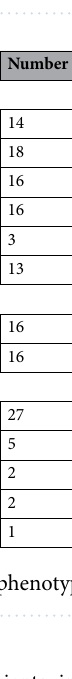
Figure 1. Pedigrees and audiograms of some of the families. All variants were identified by whole-exome sequencing and confirmed by Sanger sequencing. ( A ) Two novel variants in the CDH 23 gene were identified, c.337del, p.(Val113*) and c.3353del, p.(Gly1118Alafs*7), in a patient with Usher signs. ( B ) Two previously reported variants were identified in CDH 23: c.1515-12G > A, reclassified as likely pathogenic after manual curation, and c.1096 G > A, p.(Ala366Thr) classified as benign based on its high population frequency. ( C ) Postlingual bilateral moderate hearing loss caused by a novel heterozygous variant in EYA 4: c.580+2T > C (splicing). ( D ) One-year-old boy with nonsyndromic isolated prelingual hearing loss and no retinal or vestibular pathologies at the time of study. Novel variants c.733C > T, p.(Gln245*) and c.1344-2A > G (splicing site mutation previously reported in ClinVar) in MYO7 A were detected. ( E ) Two congenital bilateral profound cochlear implanted sisters with variants in LARS 2: novel c.1481dup, p.(Leu495Thrfs*31*) and previously reported c.1886C > T, p.(Thr629Met). ( F ) Previously reported nonsense mutation c.877C > T, p.(Arg293*) in MITF cosegregated with pathology in four affected members of the family with nonsyndromic hearing loss.